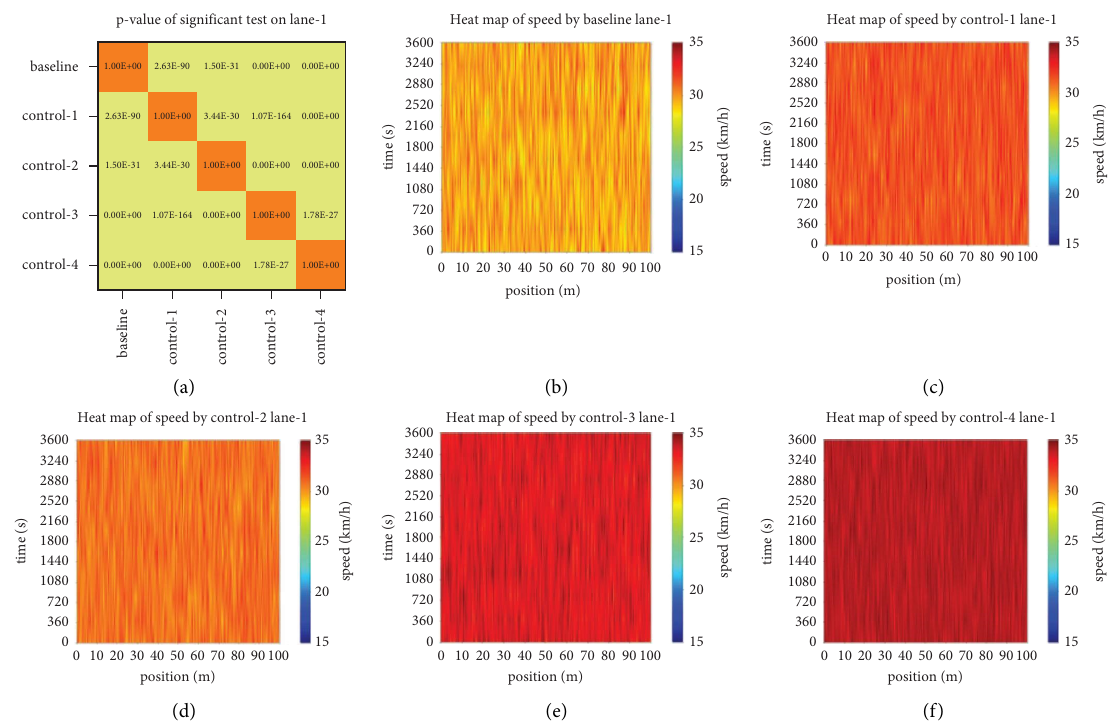
Figure 8: Heat maps of vehicle speed distributions under diferent control strategies and t -test results in lane-1. (a) T -test p value matrix. (b) Baseline (no controls). (c) Control-1 strategy (channelization left-right). (d) Control-2 strategy (channelization right-left). (e) Control-3 strategy (ramp metering). (f) Control-4 strategy (channelization and ramp